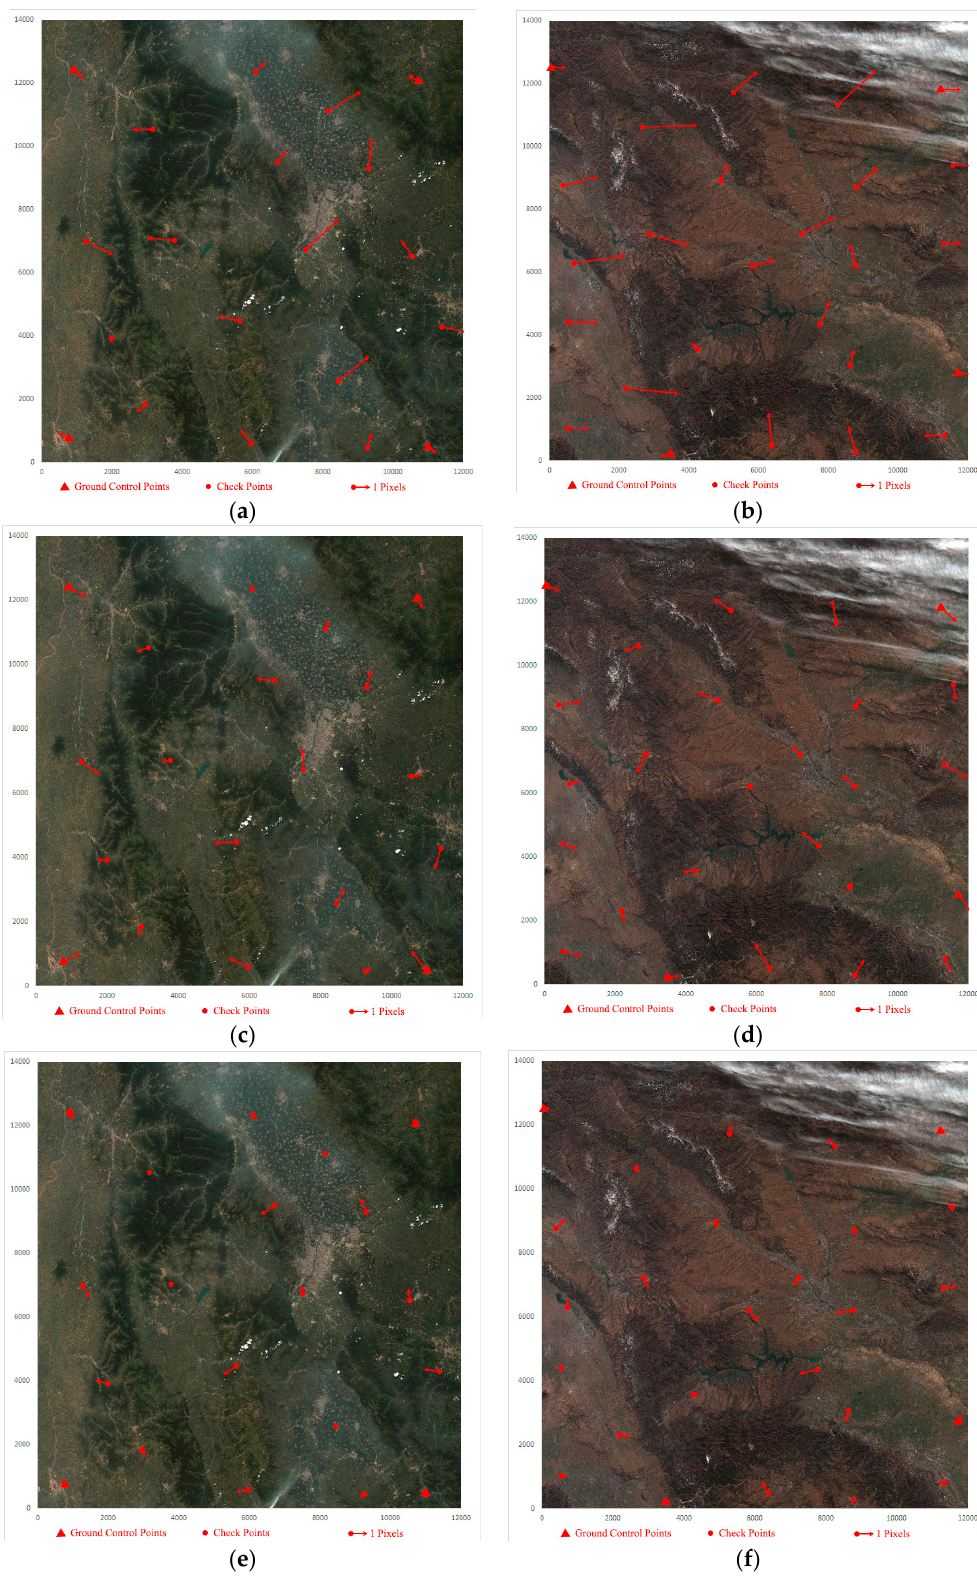
Figure 6. Orientation errors with four GCPs in ( a ) scene 068316; and ( b ) scene 125567, before correcting distortion; ( c ) scene 068316; and ( d ) scene 125567, after applying the proposed method; and ( e ) scene 068316; and ( f ) scene 125567, after applying the classic GCF method.